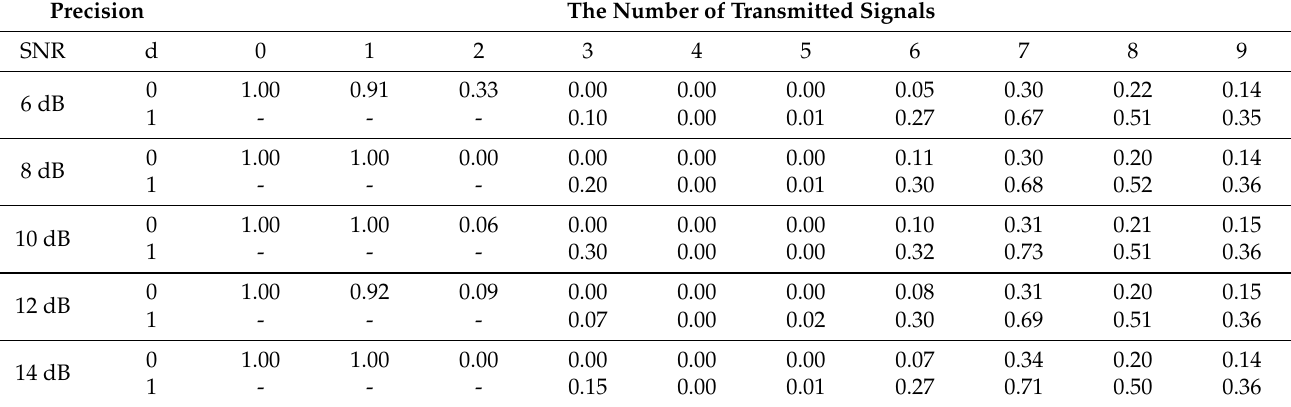
Table 5. Precision and recall of